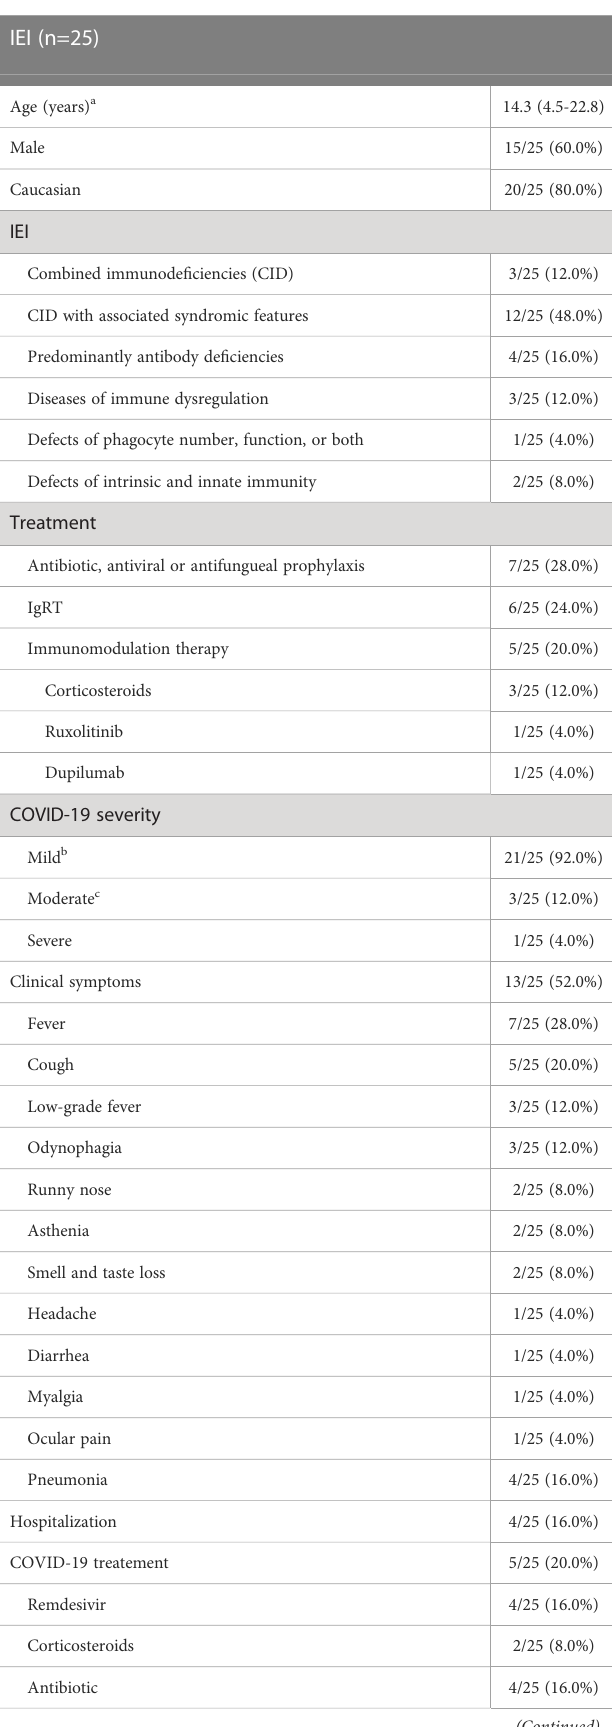
TABLE 1 Baseline features of the IEI infected with